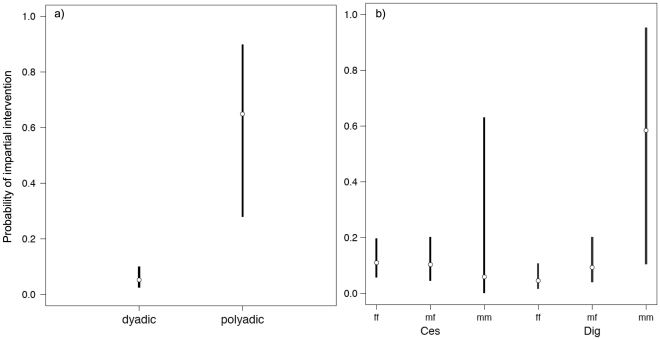
Plots showing the 95% credible intervals for a) complexity of a conflict (dyadic vs. polyadic) and for b) the interaction between class of conflict (sex-dyad combination) and identity of arbitrator (male).